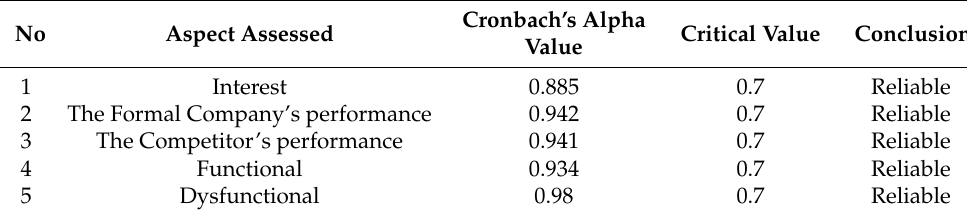
Table 7. Reliability results of the formal questionnaire using SIPA